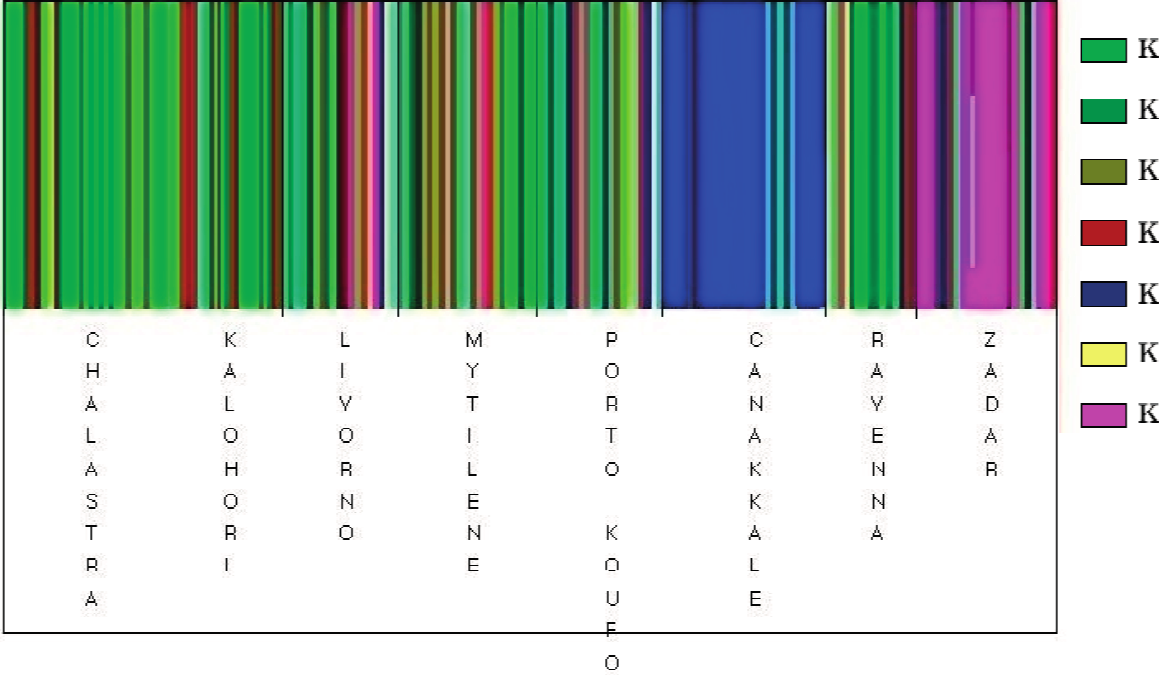
(below diagonal) and Φ p values (above diagonal). ST ST